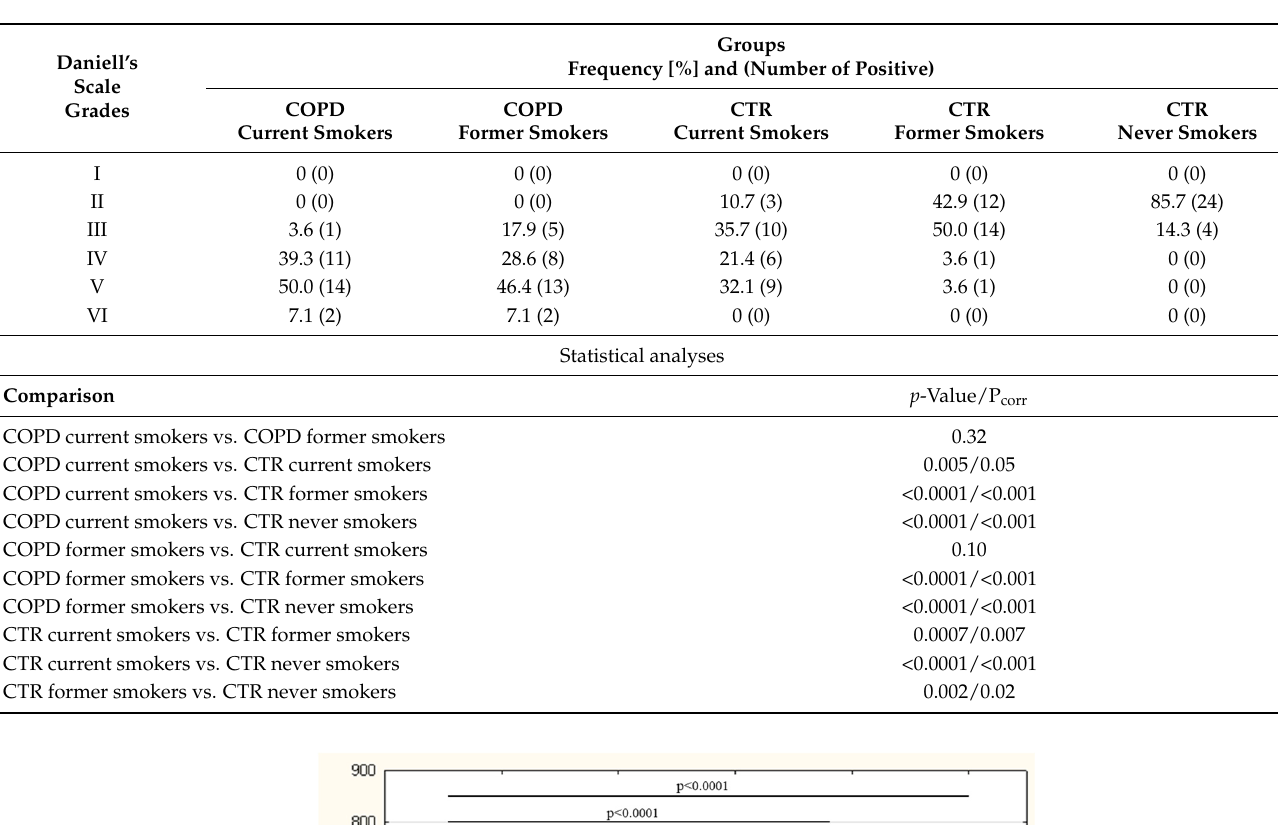
Table 2. Intergroup differences in facial wrinkles using classification by Daniell’s six-point scale.